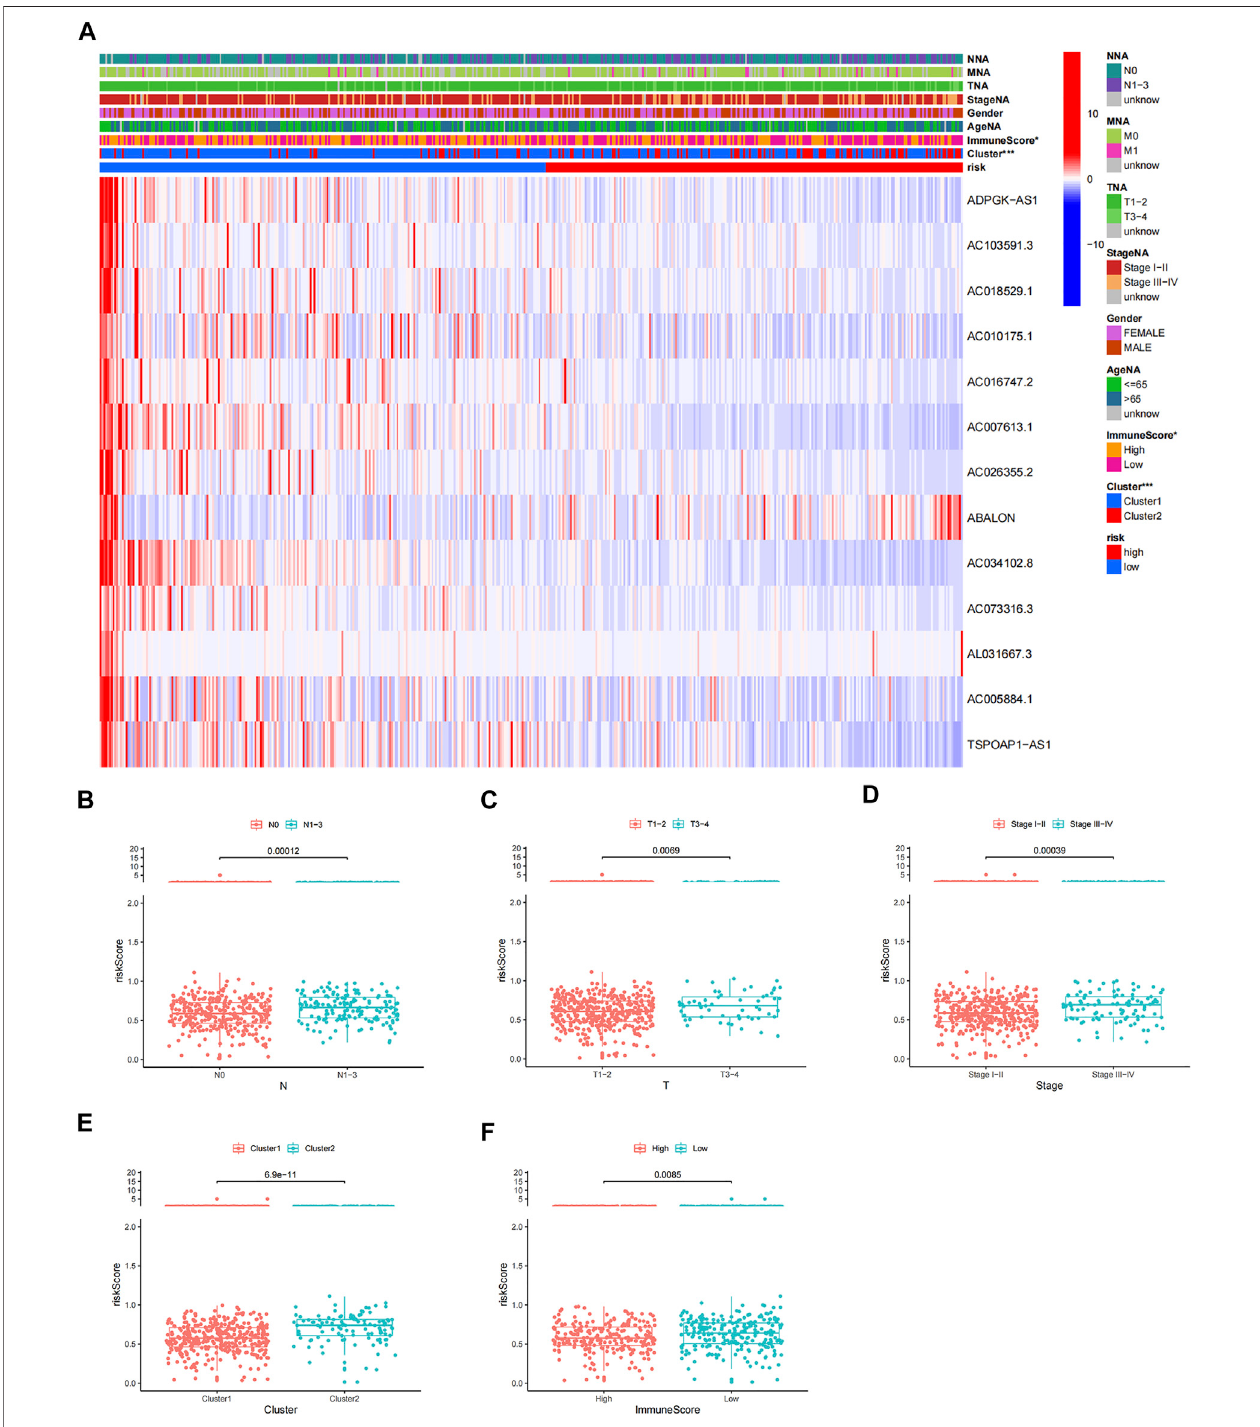
FIGURE10| Correlation analysis of riskscore and clinicopathological characteristics. (A) Heatmap of expression ofprognostic m6A-related lncRNAs in relation to age, sex, TMN stage, lncRNA-clusters, pathological stage, and immune score. Variance analysis of risk scores according to (B) N stage, (C) T stage, (D) pathological stage, (E) two clusters, and (F) different levels of immune score.